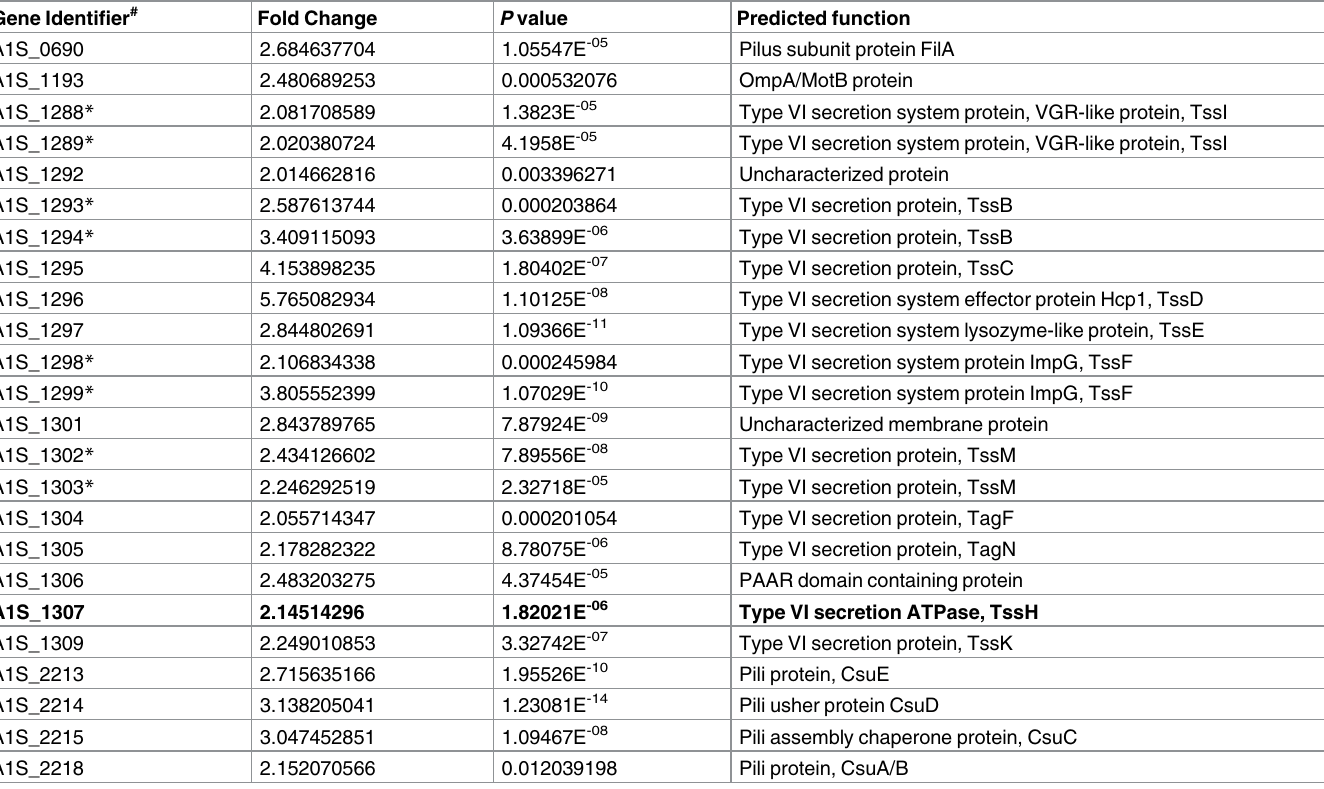
Table 3. A . baumannii ATCC 19606 T virulence-associated genes with increased expression in the presenceof mucin.